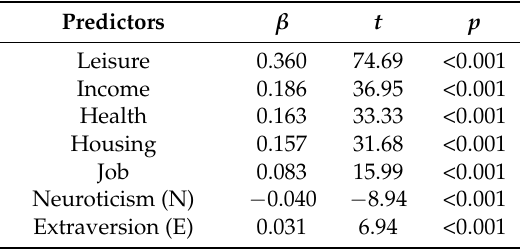
Table 3. Standardized regression coefficient ( β ), t -value, and p -value for predictors of overall satisfaction score for Survey 1. Personality measured with